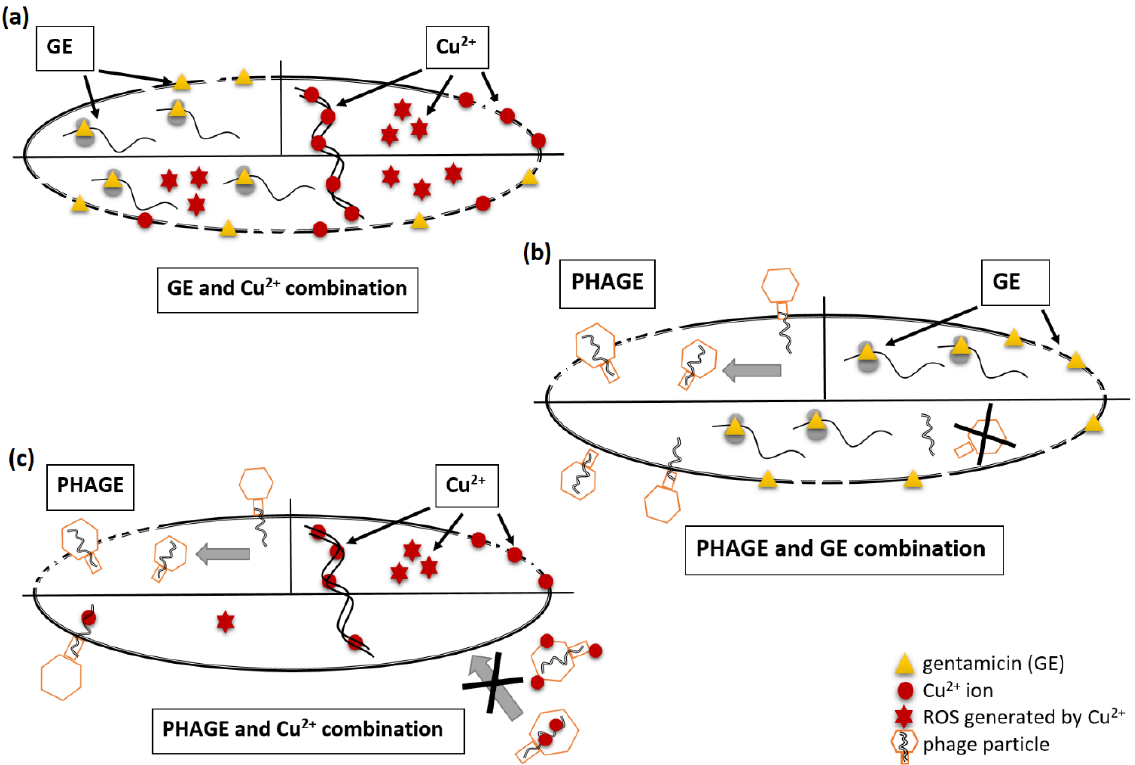
Figure 7. The proposed model of antibacterial action of tested combinations: ( a ) GE + Cu 2+ combination shows an additive antibacterial effect in enhanced ROS production, outer membrane permeabilization, and bacterial cell lysis; ( b ) simultaneous application of GE and phages results in the protein synthesis inhibition reducing an efficient phage progeny production; ( c ) Cu 2+ + phages combination causes a mutual adverse effect such as probable cupric ions sequestration by phage particles and the reduction of phage infectivity by the toxic cupric ions. Each panel ( a – c ) presents a bacterial cell divided into the top parts representing the mode of action of a particular antibacterial agent applied separately (left and right) and the bottom part of the cell with the proposed activity of combined treatment.